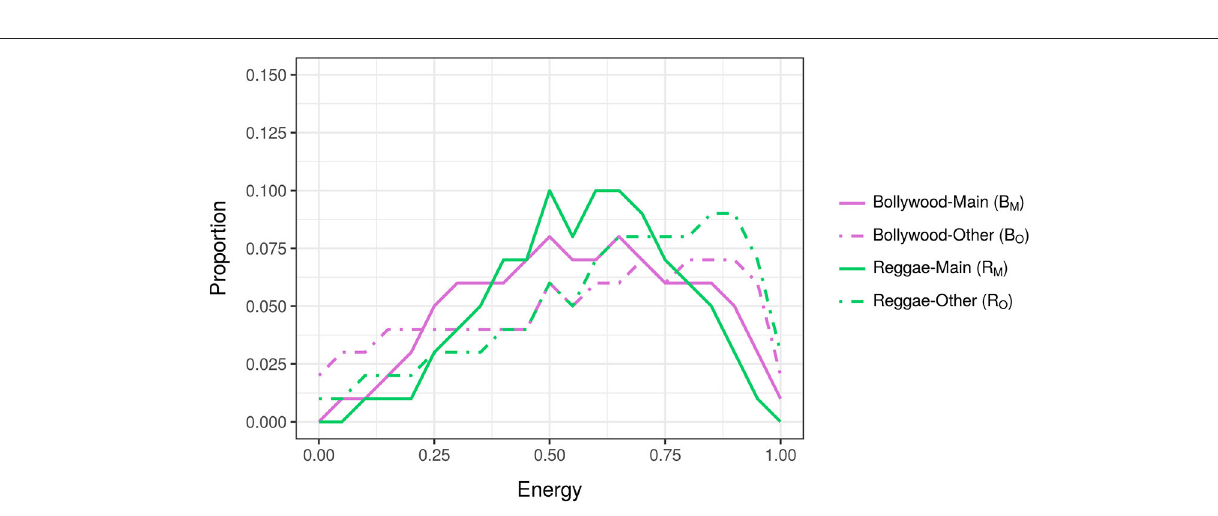
( Jazz Other = J O ). Two things are important to note: (1)